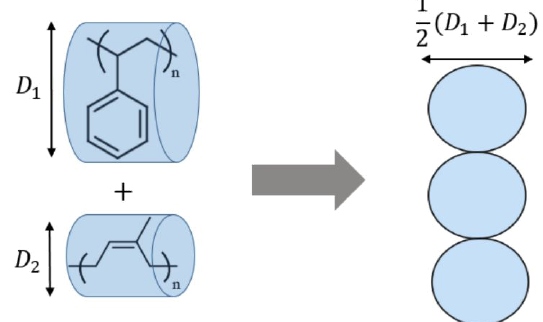
Figure 9. To relate the bead-spring model to real polymers, the bead diameter is taken as the average diameter of the real chains (such as polystyrene and polyisoprene, shown in the